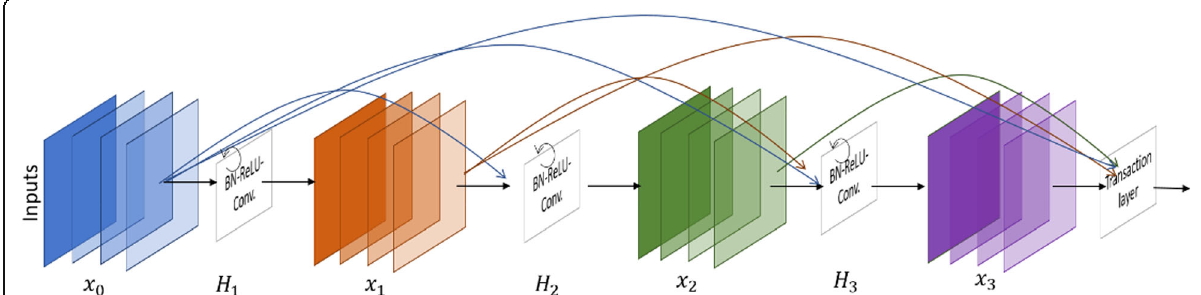
Fig. 2 The Densely Connected Recurrent Network model with recurrent, convolutional, and transition blocks